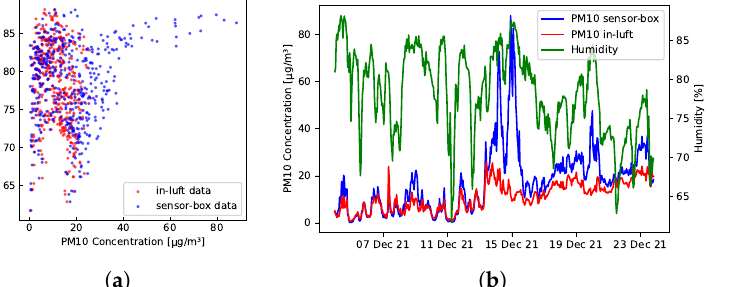
Figure 9. Hourly mean values recorded with sensor-box 1 between 4 December 2021 and 24 December 2021 in Stans, Nidwalden compared to in-luft data measured in the same time-interval. ( a ) PM 10 concentration vs. humidity; ( b ) PM 10 and humidity time-series